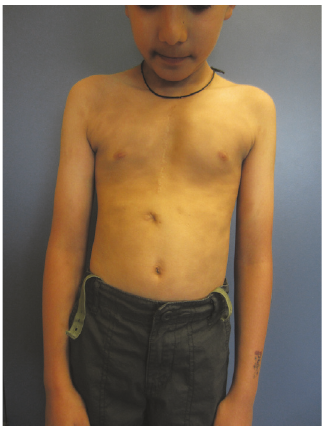
Figure 1: Well-demarcated oval ash-brown macules and patches symmetrically distributed over the anterior chest and abdomen.